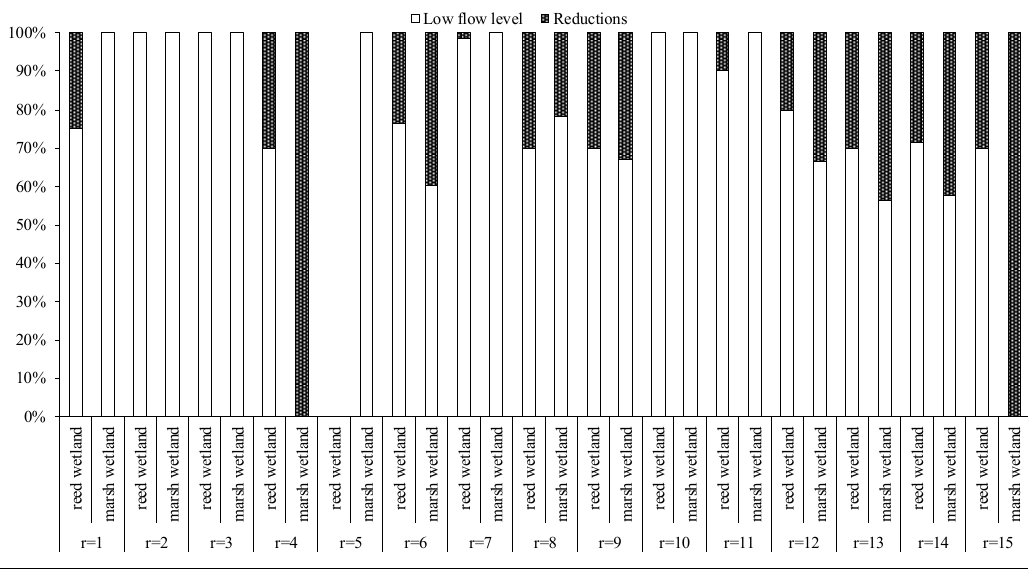
Figure 7. Reduction in initial planned restored wetland area in western Jilin Province under the scenario of a low flow level.